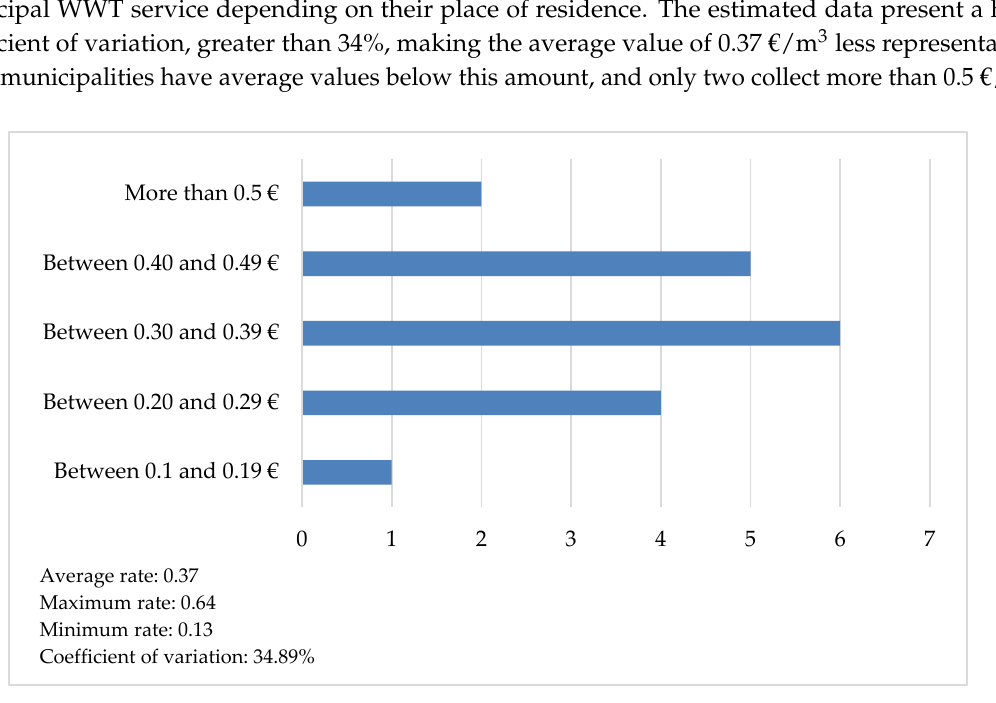
Figure 1. Number of municipalities and amount paid for WWT (€/m 3 ) in the province of Jaén. Source: own elaboration from [24].